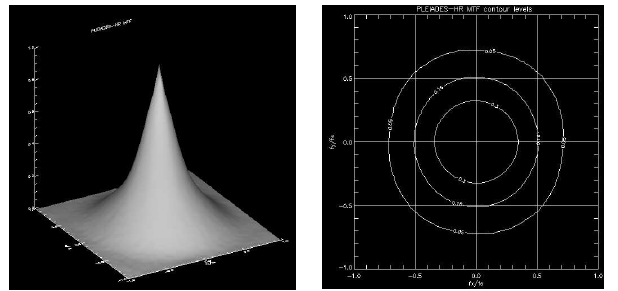
Figure 2 : PLEIADES-HR MTF measured from star acquisitions